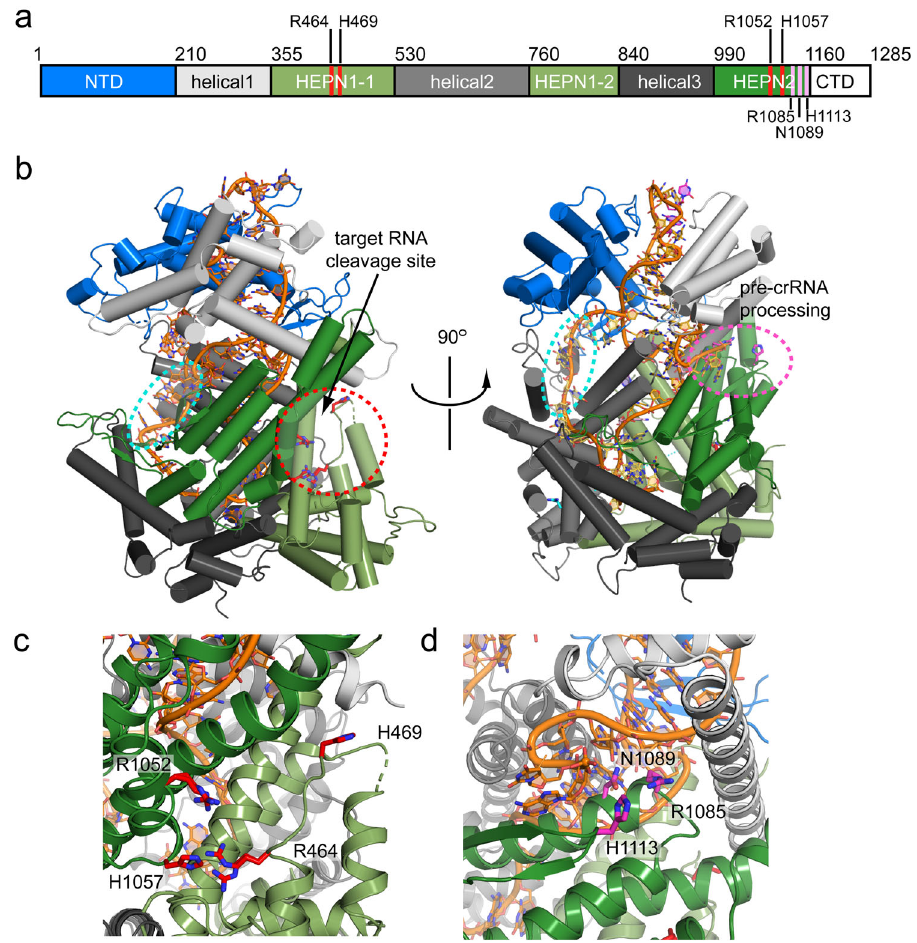
Fig. 1 Overall structure of the RcCas13a-crRNA complex. a Domain structure of RcCas13a with the residues important for the catalytic activity highlighted in red (trans-ssRNA cleavage) and pink (pre-crRNA processing), respectively. b The location of the two independent active sites are indicated by a red circle, the seed region of the crRNA (position 10 – 14) by a cyan circle. c Zoom in the RNase active site, with the residues crucial for catalytic activity (Arg 464/His 469 and Arg 1052/His 1057) highlighted as red stick model. d Close-up view of the pre-crRNA processing site, with Arg 1085, Asn 1089 and His 1113 essential for pre-crRNA cleavage (see below) highlighted in pink. The crRNA is shown as orange stick